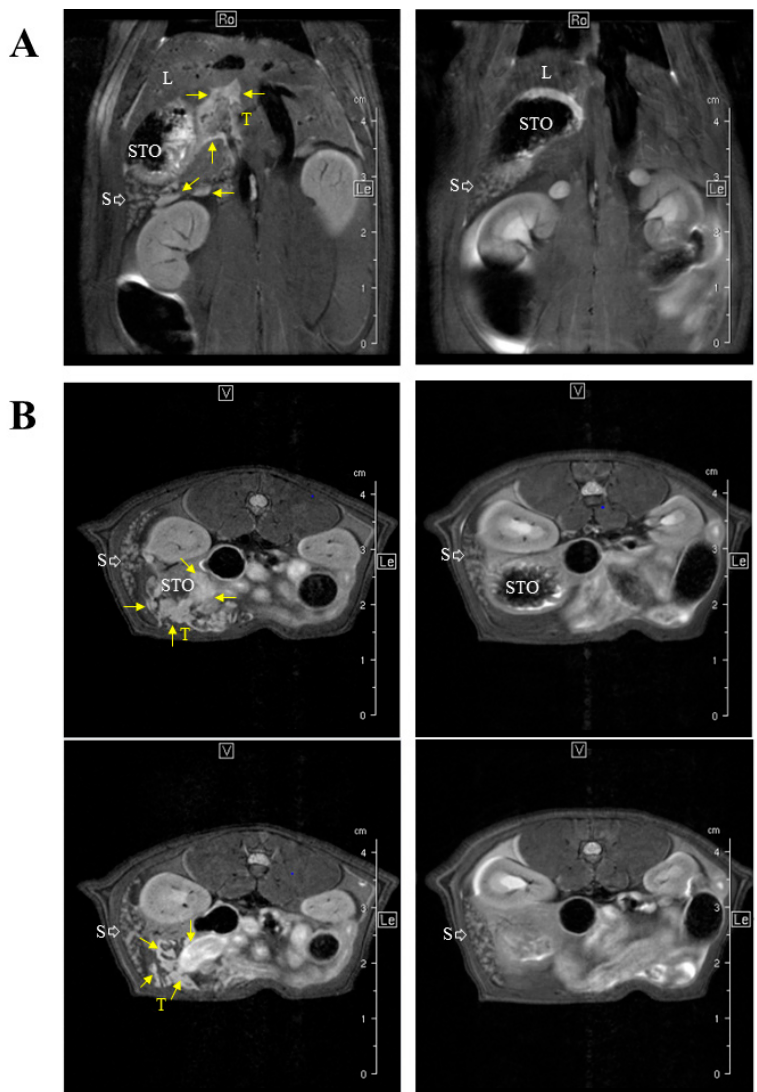
Figure 3. MRI-based staging of the M5-T1 MM model. M5-T1 tumor (T, and yellow arrows) was present as omental cakes and nodules attached to the stomach (STO) and spleen (S) on both coronal ( A ) and axial images ( B ). M5-T1 tumor was also characterized by the presence of metastatic tumor development into the liver parenchyma (L) and along the portal vein. Note the changes in volume and white pulp vs. red pulp signal intensity of the spleen in the tumor-bearing rat in comparison to normal rat